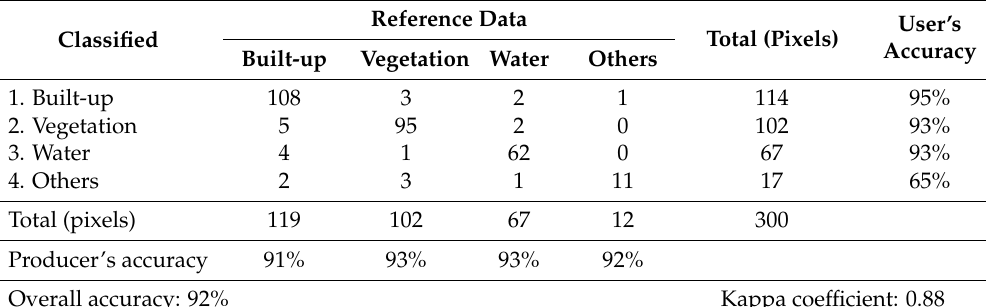
Table 3. Confusion matrix of land-use map classified from the Landsat 8 image in